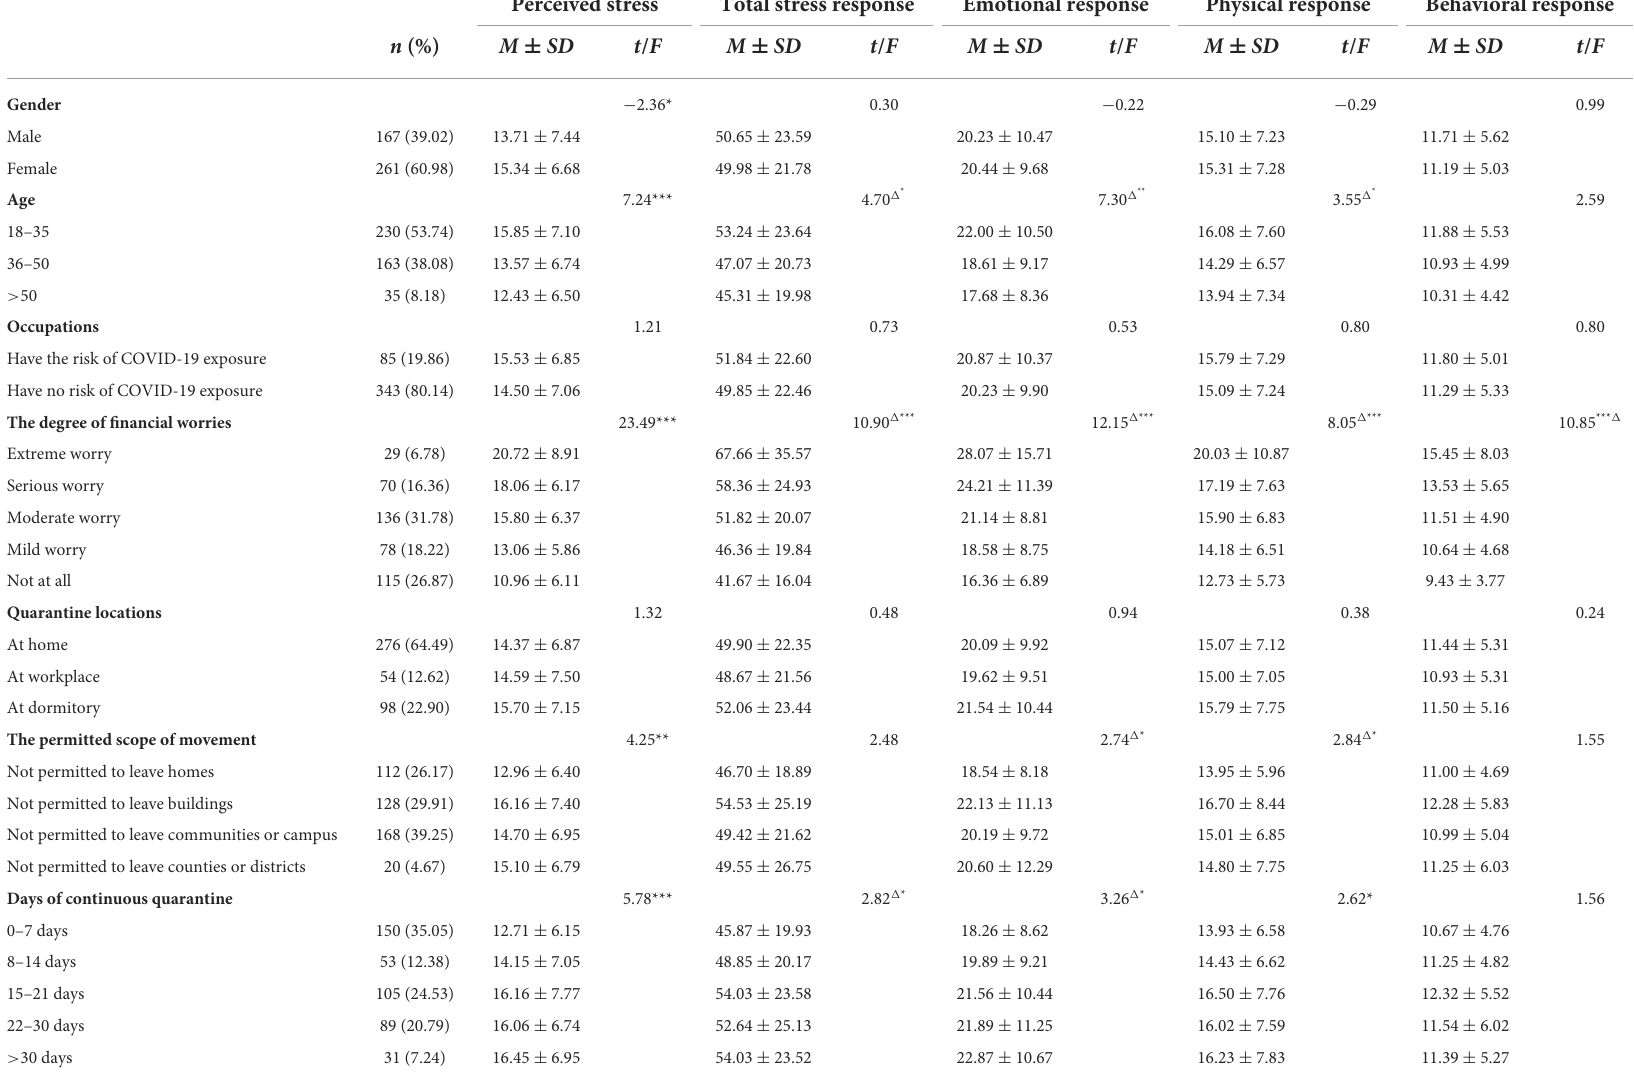
TABLE 1 Univariate analysis of factors associated with perceived stress, total stress response, emotional response, physical stress, and behavioral stress. Perceived stress Total stress response Emotional response Physical response Behavioral